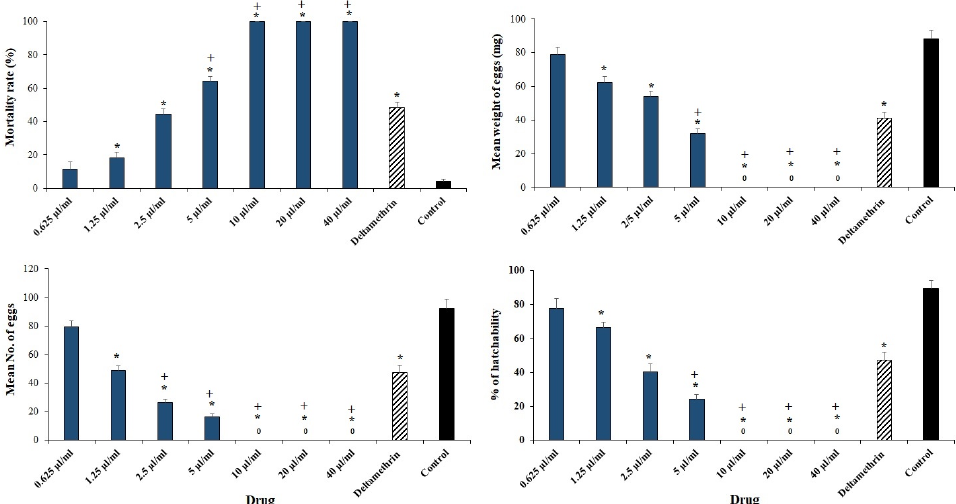
Figure 2. The in vitro effects of Elettaria cardamomum L. essential oil (ECEO) against Hyalomma anatolicum adult females by assessment of mortality rate, the mean number, weight of eggs, and hatchability percentage in immersion test. Data are stated as mean ± SD (n = 3). * p < 0.001 significant difference with control group; + p < 0.001 significant difference with deltamethrin.